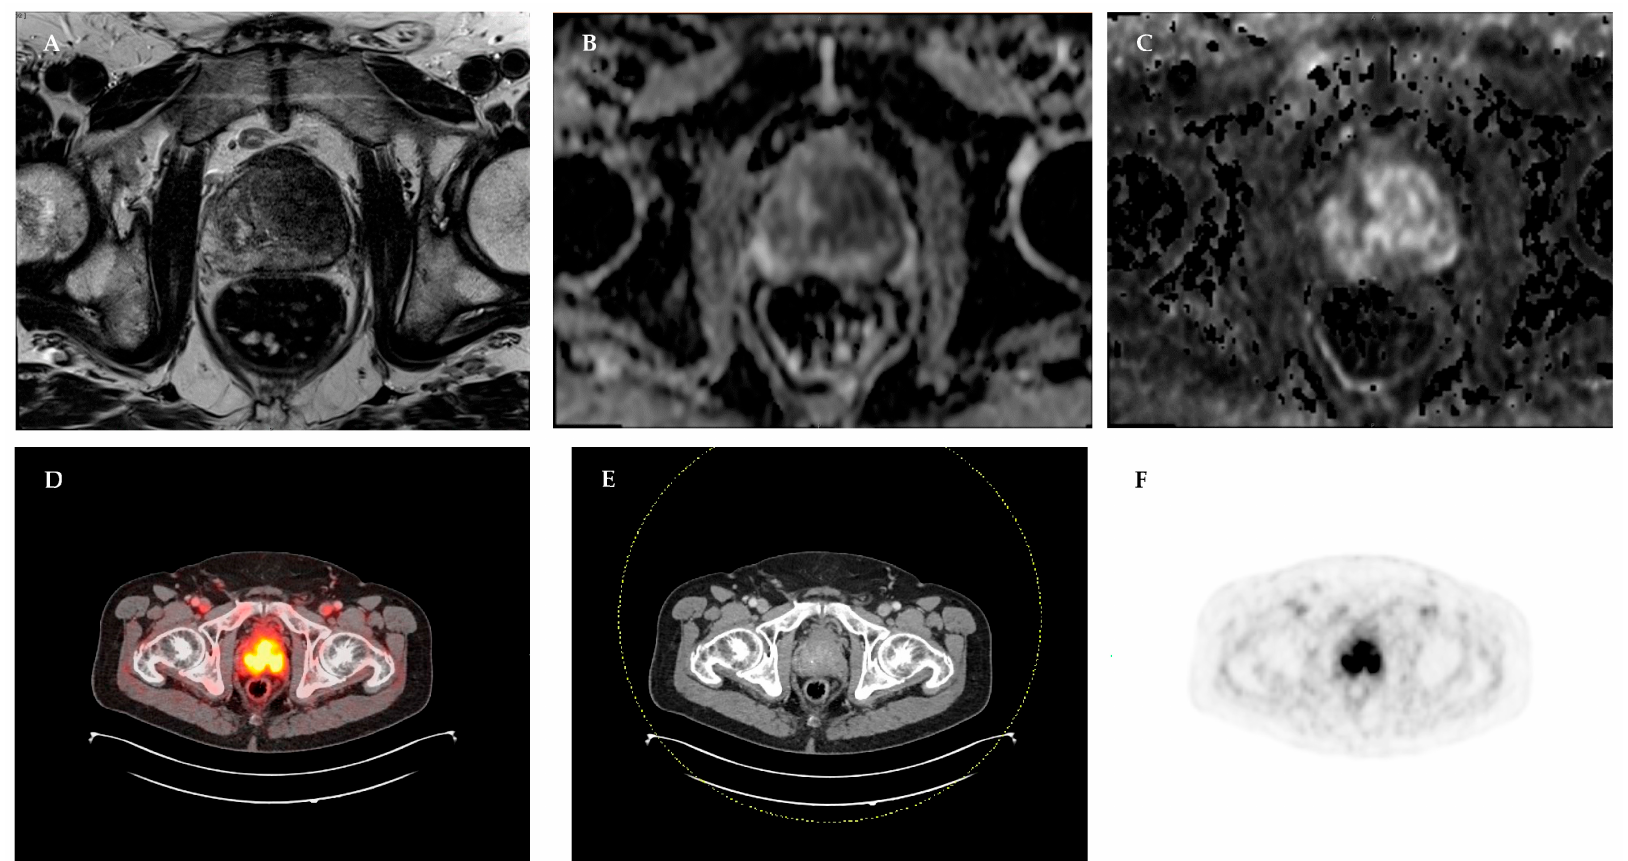
Figure 1. Preoperative mpMRI of the prostate and PSMA-PET/CT scan of a 70-year-old patient with PSA 56 ng/ml and positive DRE (Group 1) shows a large lesion from the apex to the base of the left prostatic lobe with consecutive diffusion restriction (PI-RADS 5) and enhanced uptake of PSMA-ligand. The patient underwent radical prostatectomy without prior biopsy and was diagnosed with prostate cancer ISUP 2 pT3b pN0 R1. ( A ) Axial T2-weighted sequence of mpMRI of the prostate; ( B ) ADC-map of mpMRI of the prostate; ( C ) DWI-sequence of mpMRI of the prostate; ( D ) Fused imaging of PSMA-PET/CT; ( E ) CT scan of the abdomen; ( F ) PSMA-PET scan of the abdomen. mpMRI : multiparametric magnetic resonance imaging; PSMA-PET/CT : prostate-specific membrane antigen positron emission tomography/computer tomography; PSA : prostate-specific antigen; DRE : digital rectal examination; PI-RADS : Prostate Imaging Reporting and Data System; ISUP : International Society of Urologic Pathologists; ADC : apparent diffusion coefficient; DWI : diffusion-weighted imaging.